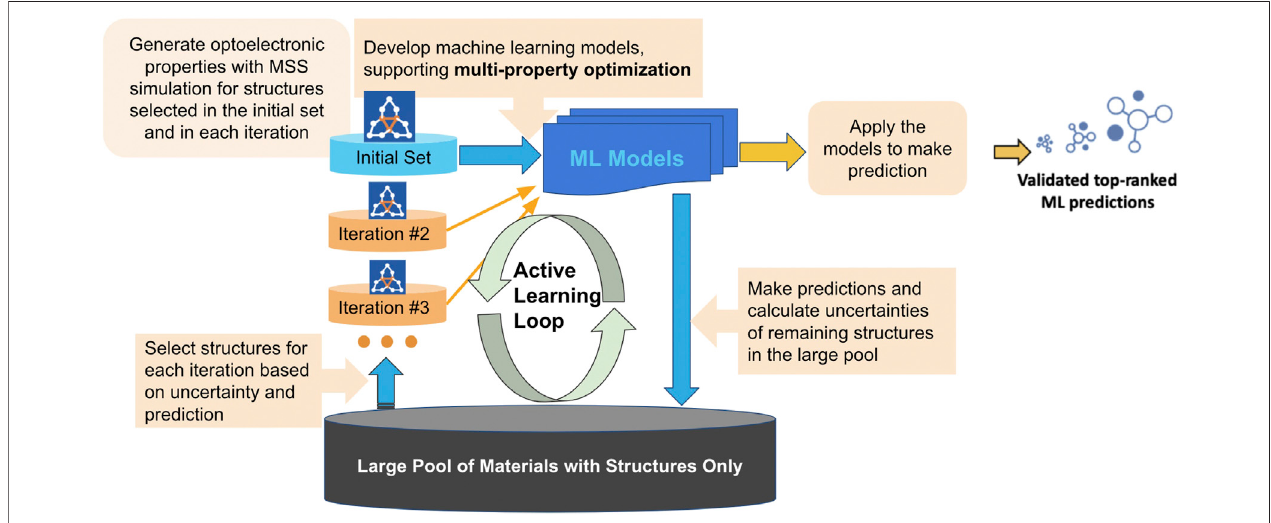
FIGURE 1 | Active Learning work fl ow for the design and discovery of novel optoelectronic molecules.